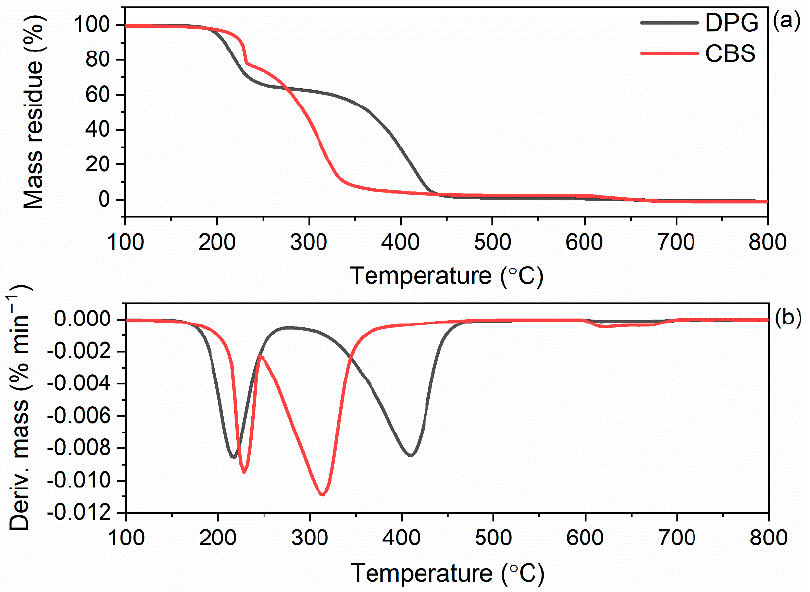
Figure 12. TG and DTG curves of pure CBS and DPG: ( a ) TG curves; ( b ) DTG curves.